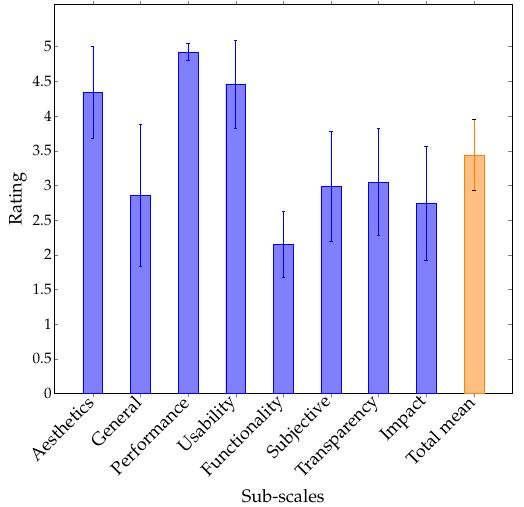
Figure 2. Sub-scale specific ratings and overall